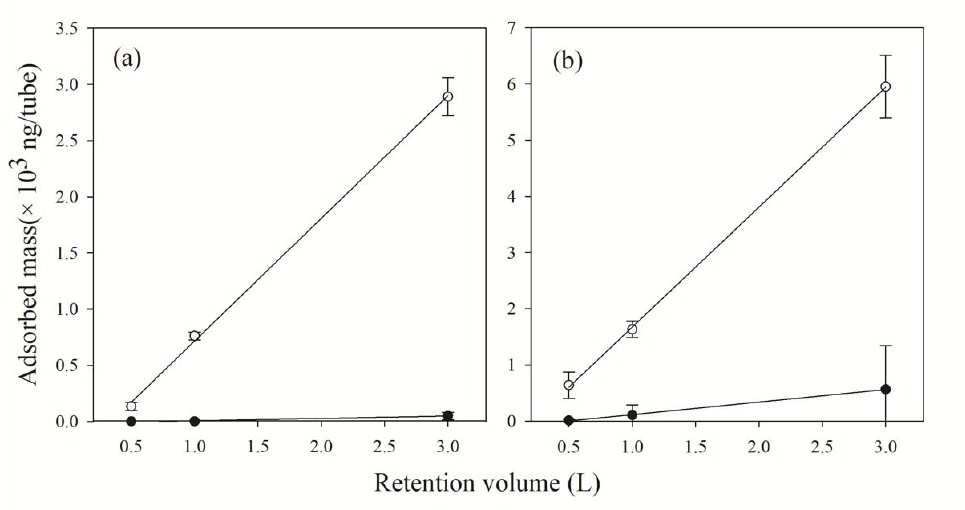
Figure 2. Adsorbed mass of the main and backup tubes of S-Tube for two different inlet gas concentrations of total volatile organic compounds; ( a ) 440 ppbv, and ( b ) 880 ppbv. The open circles represent the adsorbed mass of the main tubes and the closed circles represent the adsorbed mass of the backup tubes.